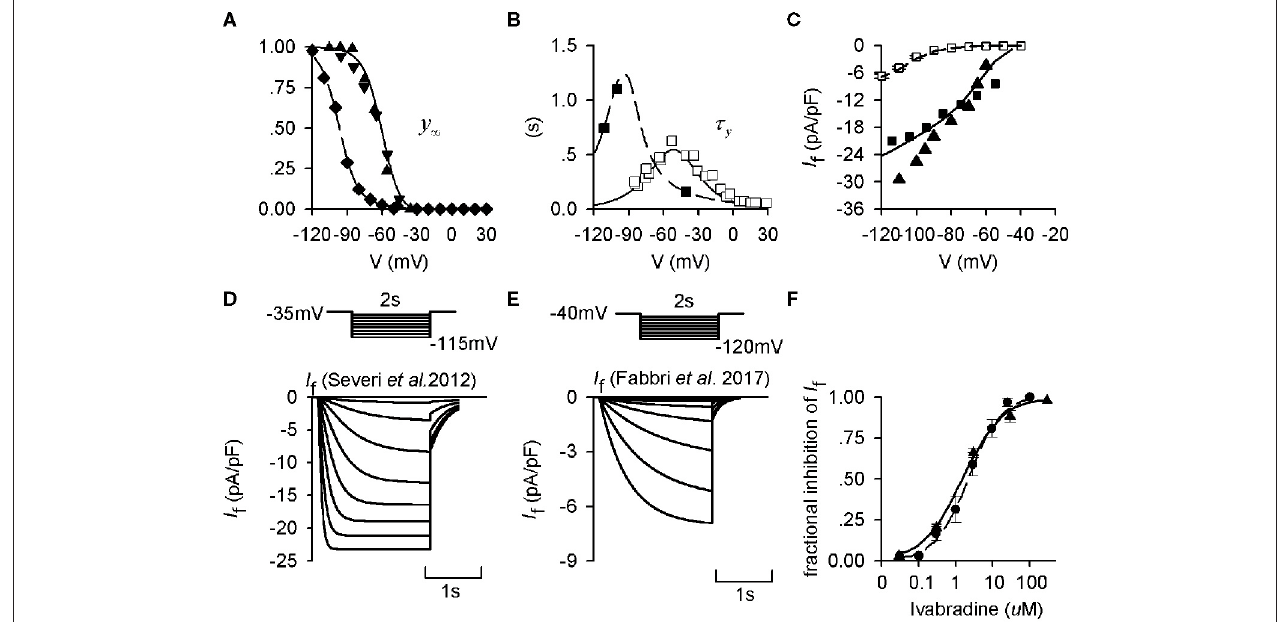
FIGURE 1 | Kinetics of I f from experimental and mathematical modeling data. (A) Steady-state activation curves in rabbit and human and SAN cells, which were used to fit I f formulations for the Severi et al. (2012) rabbit (solid lines) and the modified Fabbri et al. (2017) human (dashed lines) models. Experimental data from Altomare et al. (2003) ( N ), Barbuti et al. (2007) ( H ), and Verkerk et al. (2007b) ( (cid:7) ) are also shown. (B) Corresponding activation time constant of I f for human and rabbit SAN cells. Experimental data from Difrancesco et al. (1989) ( (cid:3) ) and Verkerk et al. (2007b) ( (cid:4) ) are also shown. (C) Computed I - V relationship for the human- (dashed line) and rabbit-like (solid line) models, which are compared with experimental data from the study of Verkerk et al. (2007b) ( (cid:3) ) for the human SAN cells, Zaza et al. (1996) ( (cid:4) ) and Goethals et al. (1993) ( N ) for the rabbit SAN cells. (D,E) Voltage-clamp protocol and simulated time traces of I f during voltage-clamp for the rabbit and human I f model. (F) Dose-dependent effect of ivabradine on I f in rabbit SAN cells. Experimental data of Bois et al. (1996) (•) and Bucchi et al. (2002) ( N ) were based to develop the concentration-response curves as shown by the solid line and dashed line